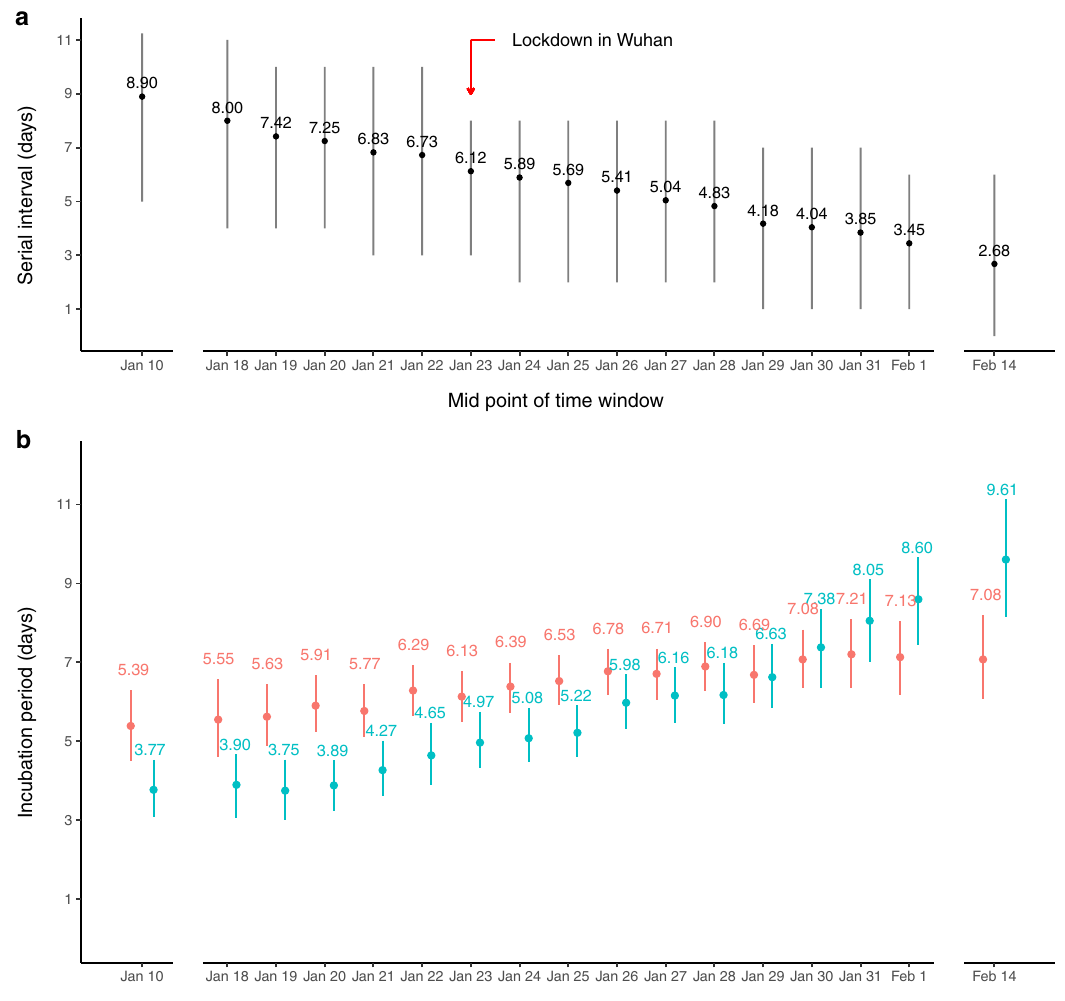
Fig.3|Temporalestimatesofforwardserialintervals(SIs),forwardincubation periods (IPs) of infectees, and backward IPs of infectors. a Empirical mean and inter-quartile range (IQR) of forward SI. The black dots and segments represented the empiricalmean and IQR,respectively. Red arrowindicates lockdown inWuhan andtheimplementationofpublichealthsocialmeasures(PHSMs)sinceJanuary23, 2020.Samplesize(numberoftransmissionpairs)ineachtimewindow( X -axisfrom lefttoright)forempiricalmeanandIQRofSIreferencedbyinfectoronset:116,110, 146, 191, 218, 248, 257, 275, 291, 295, 270, 265, 231, 218, 188, 166, 163, respectively. b The estimated mean of forward IP of infectees (in red) and backward IP of